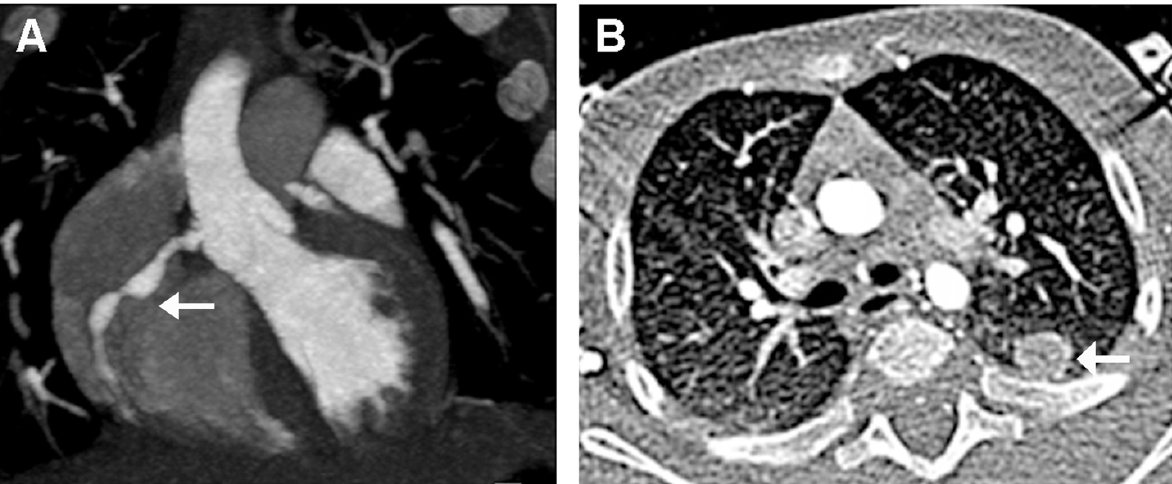
Figure 4. Cardiac CT performed 4 days after hospital admission. ( A ): “Beaded appearance” (indivated by arrow) of the aneurysmatic dilatations of the right CA. ( B ): Lung nodule (indicated by arrow) in the left upper lobe.